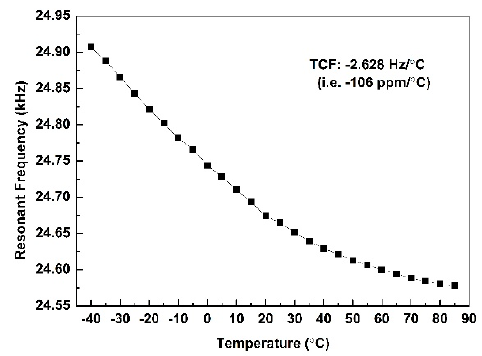
Figure 12. The temperature characteristic of the AlN accelerometer tested from − 40 °C to 85 °C.